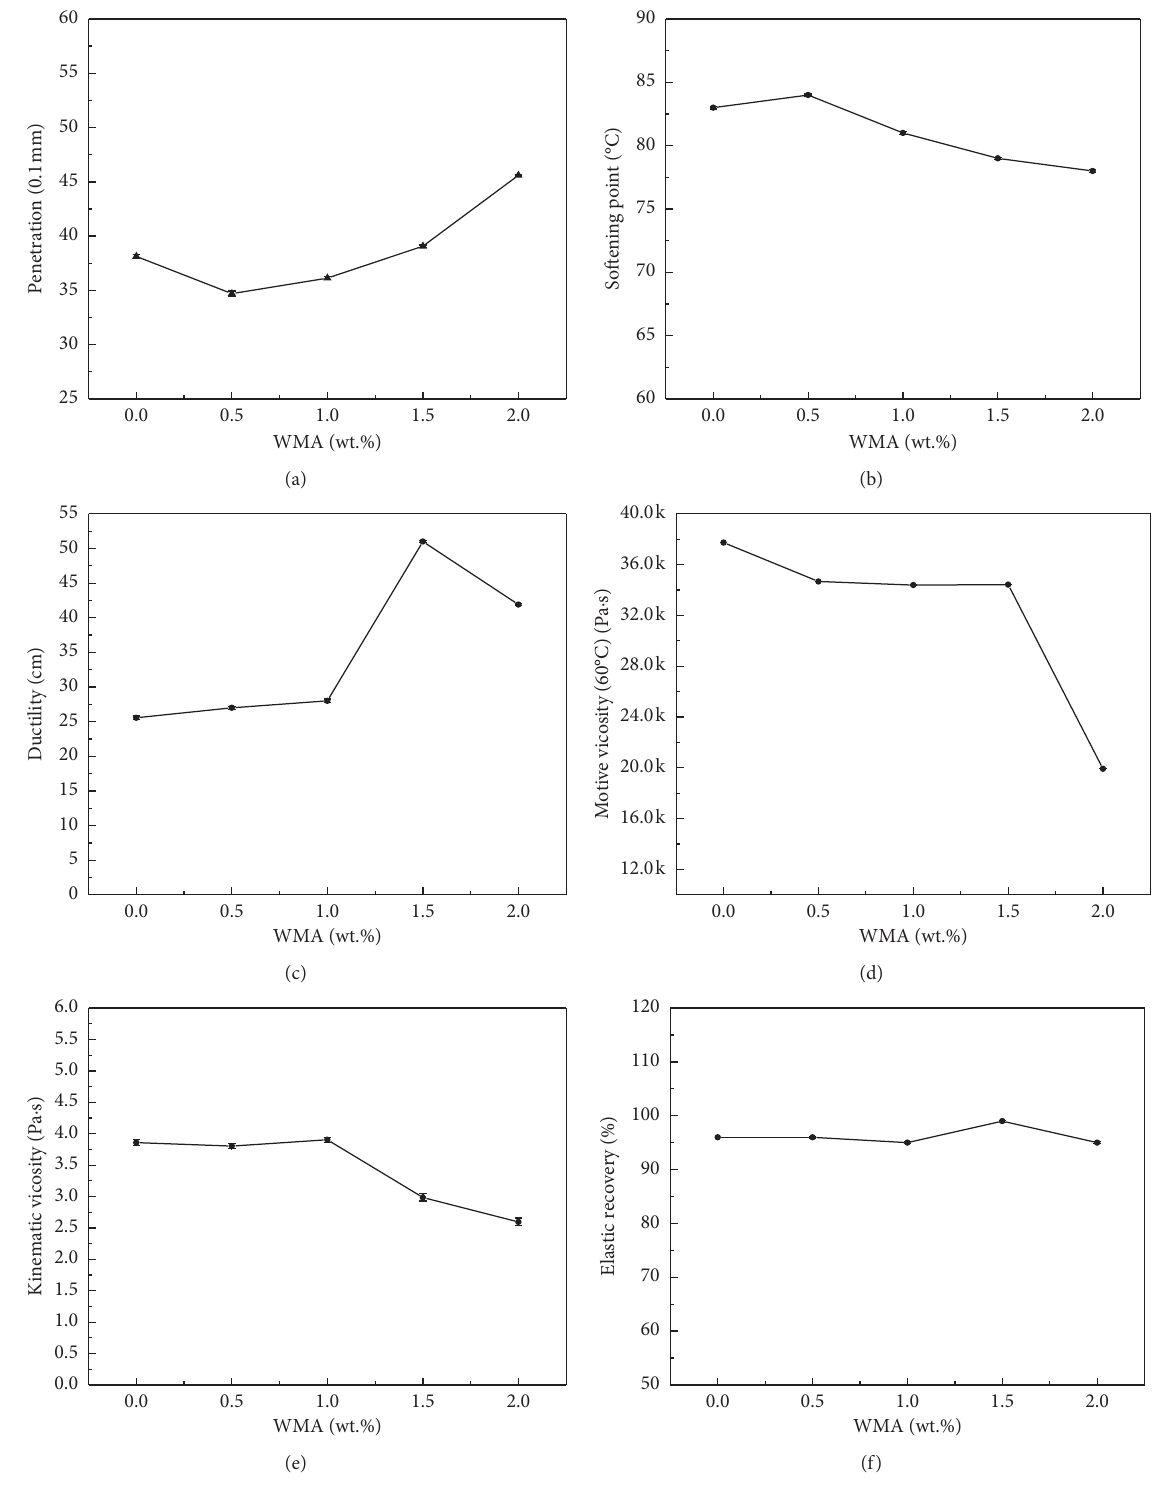
Figure 2: Physical properties of warm-mix HVA: (a) penetration; (b) softening point; (c) ductility; (d) motive viscosity (60 ° C); (e) kinematic viscosity (135 ° C); (f) elastic